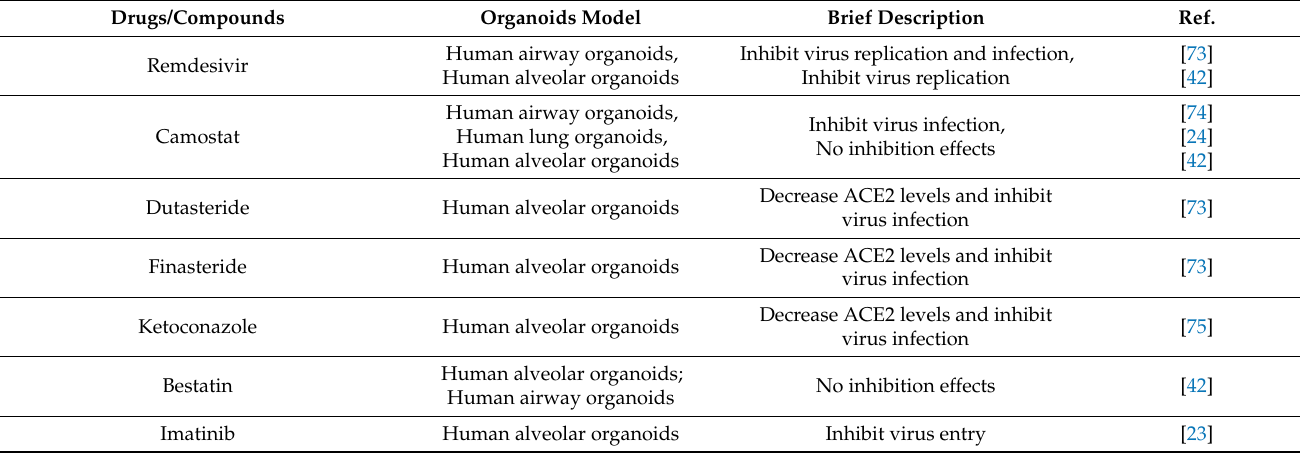
Table 2. COVID-19 drug research on lung